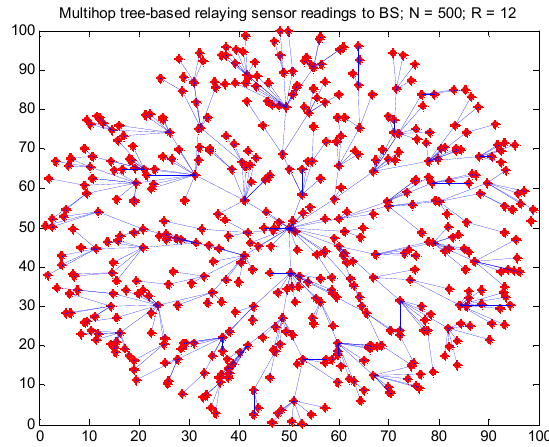
] ) between all toBS ≥ 1 L up to i Figure 6. A random network with 500 sensors distributed in a circular sensing area with the radius R